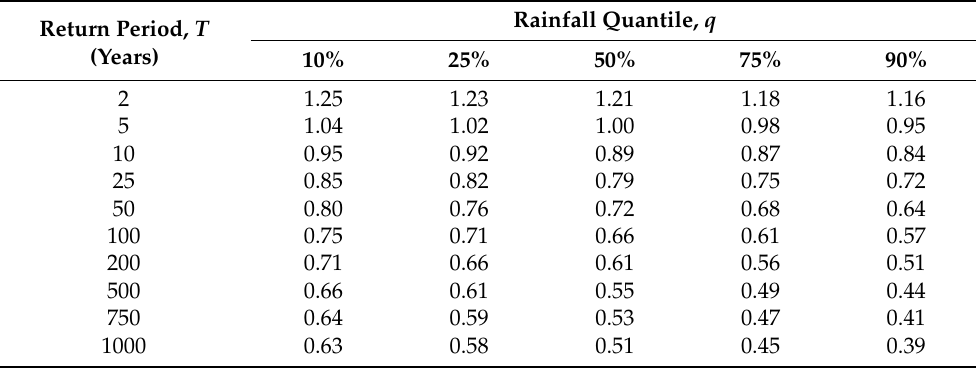
Table 4. Adjustment factors to reference time of